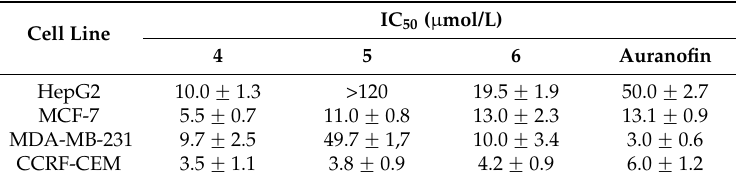
Table 2. IC 50 concentrations of 4 , 5 , 6 and auranofin against HepG2, MCF-7, MDA-MB-231) and CCRF-CEM cells. The cells were incubated with the compounds for 24 h (cytotoxic effect); results are expressed as means ˘ SEM of repeated